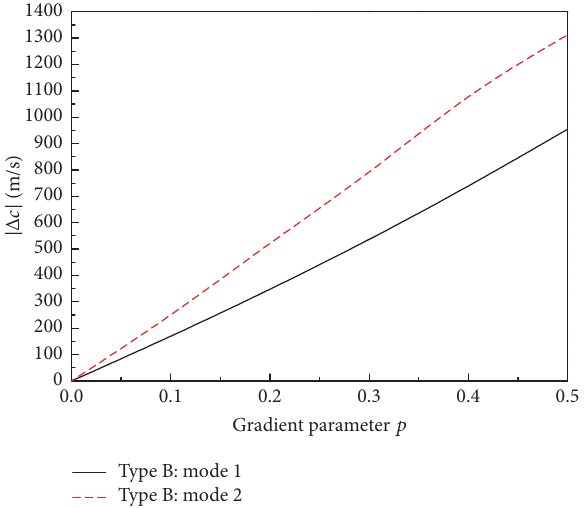
Figure 5: The influence of gradient parameter on the increment of phase velocity with subsurface damage Type